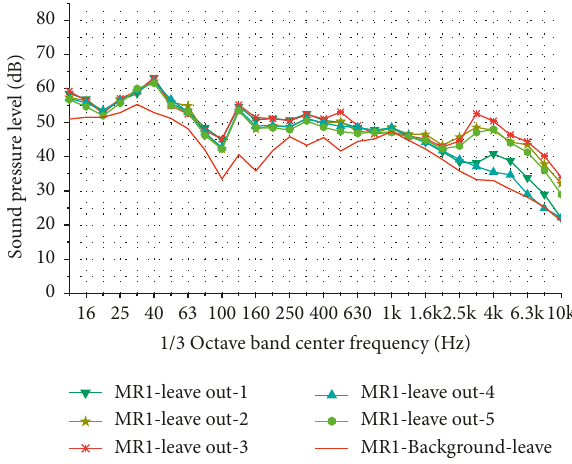
Figure 12: 1/3 octave frequency spectrum for measurement points